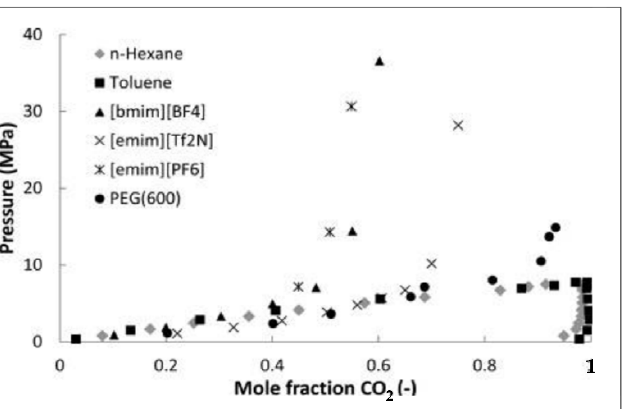
Figure 2. Comparative analysis of CO 2 -ILs systems with the VLE physical behavior of CO 2 and conventional solvent systems. At moderate pressure, the conventional solvent presents a critical point, while the IL system does not present this critical point. With permission from Ref. [41]. Copyright 2012, American Chemical Society. Table 2. Structures of anions and cations commonly used for synthesis of ILs.